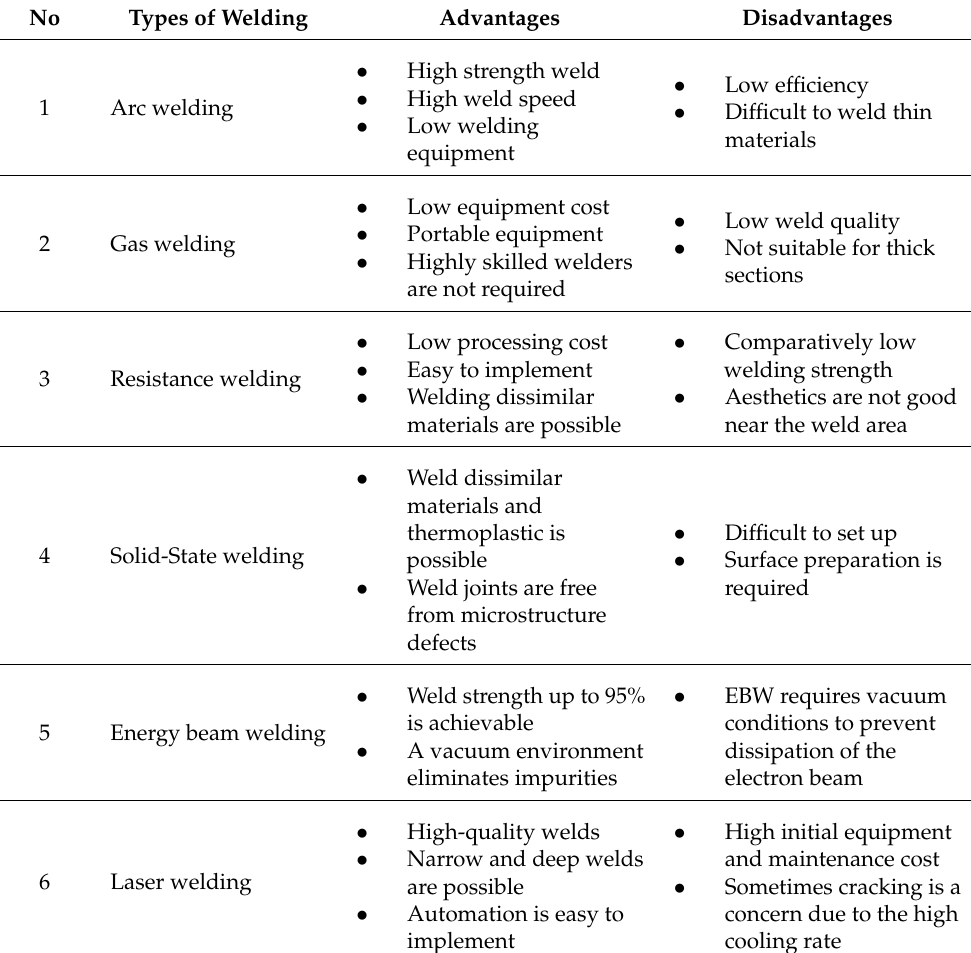
Table 1. Different welding